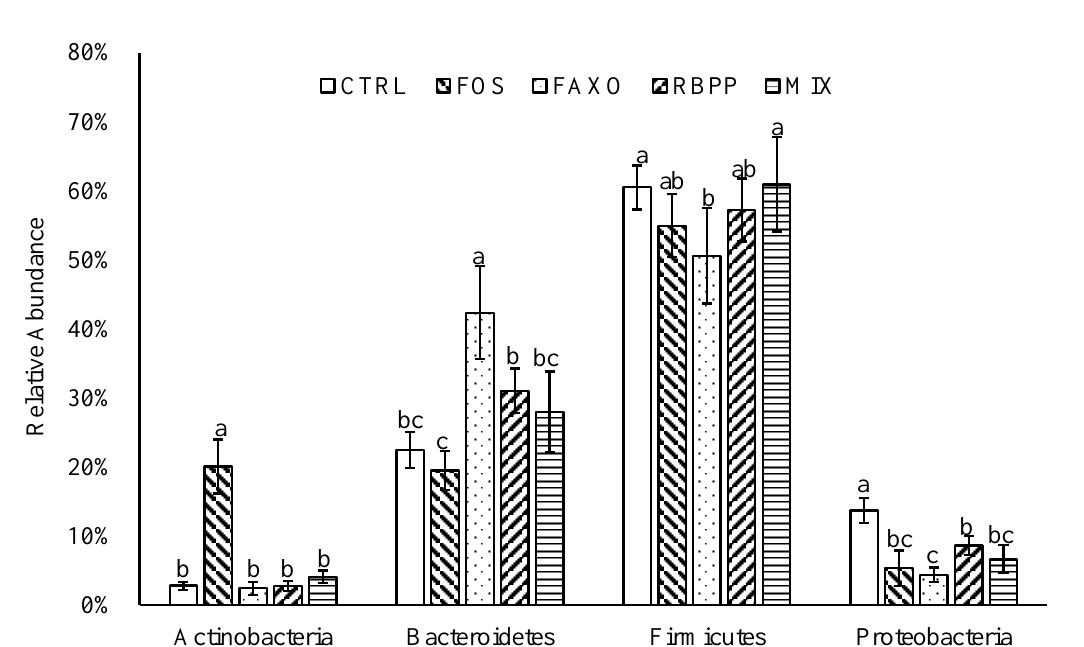
Figure 2. Microbiota composition at phylum level after 24 h incubation with different substrates. Data are expressed as mean ± SEM. Different letters in the same phylum denote significant difference ( p < 0.05). CTRL: no substrate, FOS: fructooligosaccharides, FAXO: feroloylated arabinoxylan oligosaccharides, RBPP: rice bran polyphenols, MIX: mixture of FAXO and